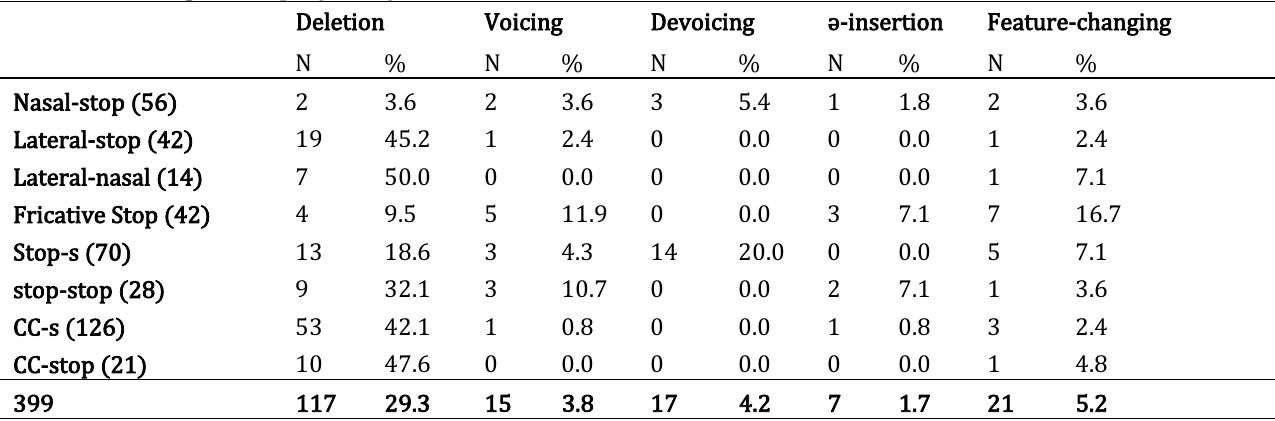
Table 3. Strategies employed by ESL learners Deletion Voicing Devoicing ə -insertion